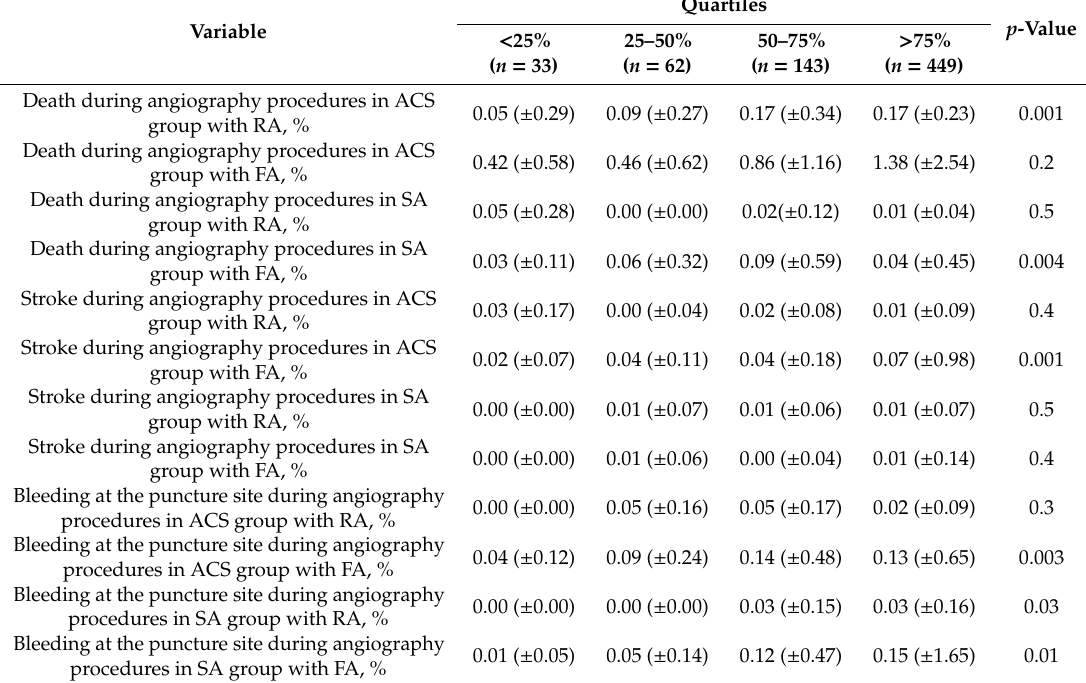
Table 5. Clinical outcomes of angiography performed by operators divided into quartiles depending on operator’s utilization of radial access site. Data presented separately for stable angina and acute coronary